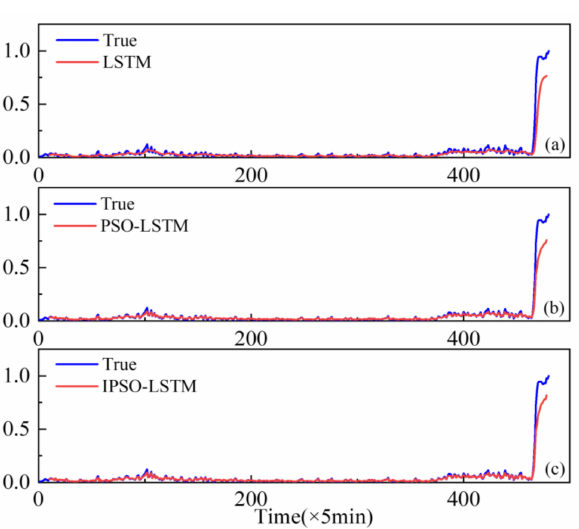
Figure 15. Performance degradation predictions of the roller bearings for the: ( a ) LSTM; ( b ) PSO- LSTM; ( c ) IPSO-LSTM.